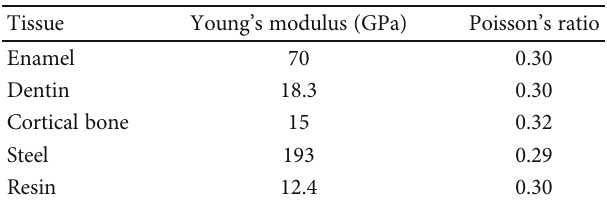
Table 2: Mechanical properties used in the